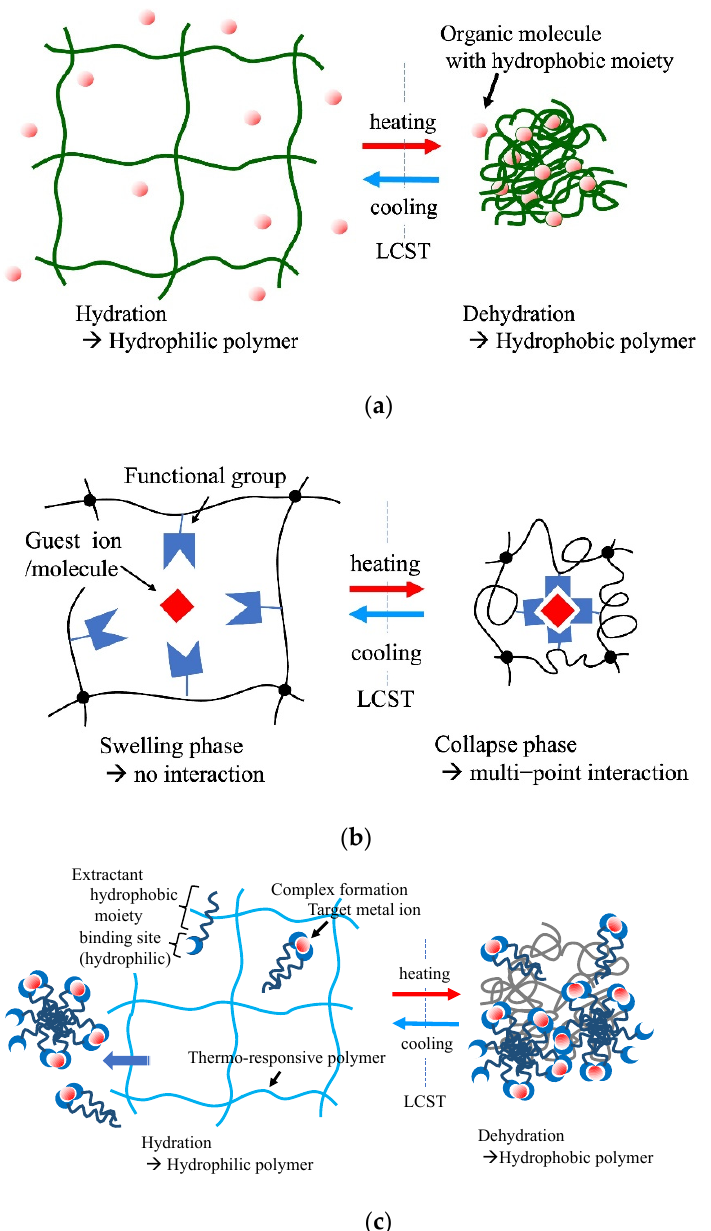
Figure 3. Thermoresponsive adsorption control using amphiphilic polymer hydrogel in aqueous systems, ( a ) adsorption through hydrophobic interaction between the thermoresponsive hydrogel and the molecules with hydrophobic moieties, ( b ) selective multipoint interaction, ( c ) solid-phase extraction of metal ions.